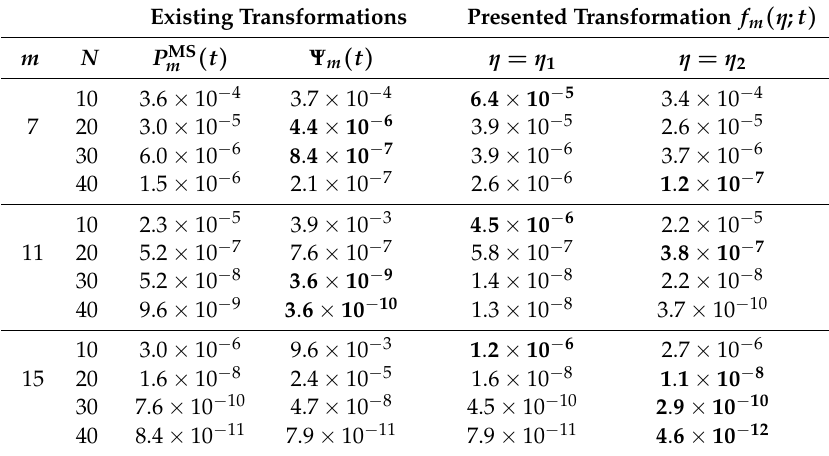
Table 1. Relative errors of the N -point Gauss-Legendre quadrature rule corresponding to the existing transformations P MS m ( t ) , Ψ m ( t ) and the presented transformation f m ( η ; t ) for the interior-point